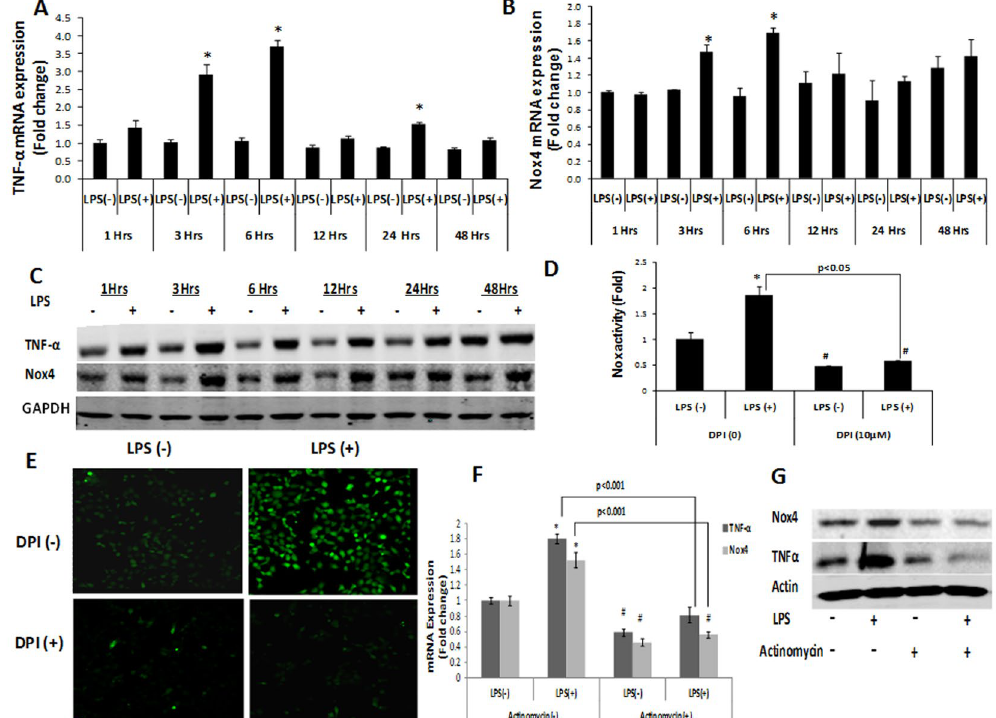
Figure 1. LPS stimulation increased TNF- α and Nox4 expression. Huh7 cells were either treated with LPS (1 µ g/ml) or PBS for up to 48 hrs, and analyzed for TNF- α ( A ) and Nox4 ( B ) mRNA expression by qRT-PCR. Data was normalized with GAPDH mRNA and calculated by ΔΔ Ct method and expressed as fold increase from the control. ( C ) TNF- α and Nox4 protein levels in Huh7 cells after LPS treatment were determined by western blotting. ( D ) Nox enzyme activities were determined in Huh7 cells either untreated or pretreated with DPI (10 µ M) for 30 minutes before 6 hrs of LPS stimulation by monitoring NADPH-dependent and SOD-inhibited reduction of cytochrome c, as described in materials and methods. # indicates statistically significant difference from DPI (0) LPS ( − ) (p < 0.05). ( E ) Huh7 cells either untreated or pretreated with DPI (10 µ M) for 30 minutes before 3 hrs of LPS stimulation. Then, cells were labeled with 5 µ M CM-H2DCFDA for 15 min and intracellular generation of H 2 O 2 was monitored by confocal microscopic analysis of DCF fluorescence. ( F , G ) Nox4 and TNF- α mRNA and protein levels in Huh7 cells either untreated or treated with Actinomycin D (1 µ M) for 30 minutes before 3 hrs of LPS stimulation. # indicates statistically significant difference from control LPS ( − ) (p < 0.05). * indicates statistically significant difference from the corresponding controls (p < 0.05). Lines with p values also indicate statistically significance (p < 0.05) between the